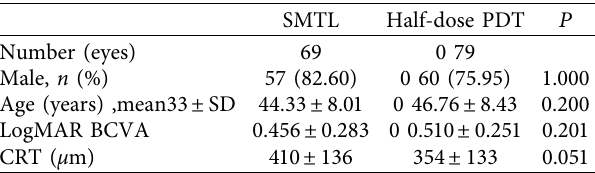
Table 1: Baseline characteristics of the SMTL and half dose-PDT